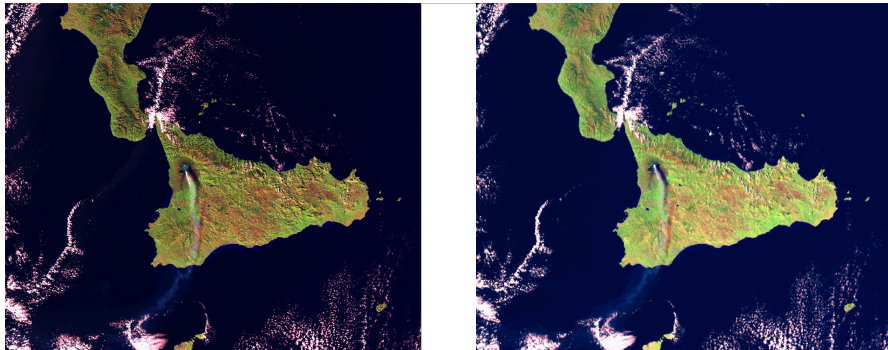
Figure 12. Sea and land surface temperature radiometer (SLSTR) stereo pair for an eruption of Mt Etna, Sicily on 27 December 2018 at 09:25 UT. The images are placed so that a third image can be formed by staring at the pair and going slightly “cross-eyed”. Elevated clouds will appear to stand out from the